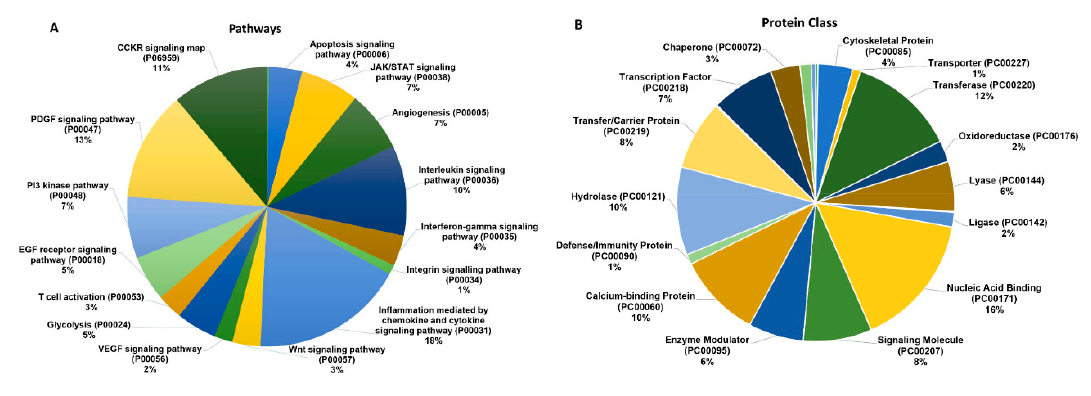
Figure 2. B7-H3 is associated with various cancer signaling pathways in MB exosomes: ( A ) results from mass spectrometry conducted on exosomes derived from B7-H3 OE D283 cells. Pie chart of mass spectrometry data uploaded to PANTHER (pantherdb.org) for annotation. GO annotation for molecules associated with each major cell signaling pathway is visualized. ( B ) Pie chart of mass spectrometry data annotating molecules based on protein class. Percentages indicate percent of all molecules assessed via LC/MS-MS that make up the enriched pathway.